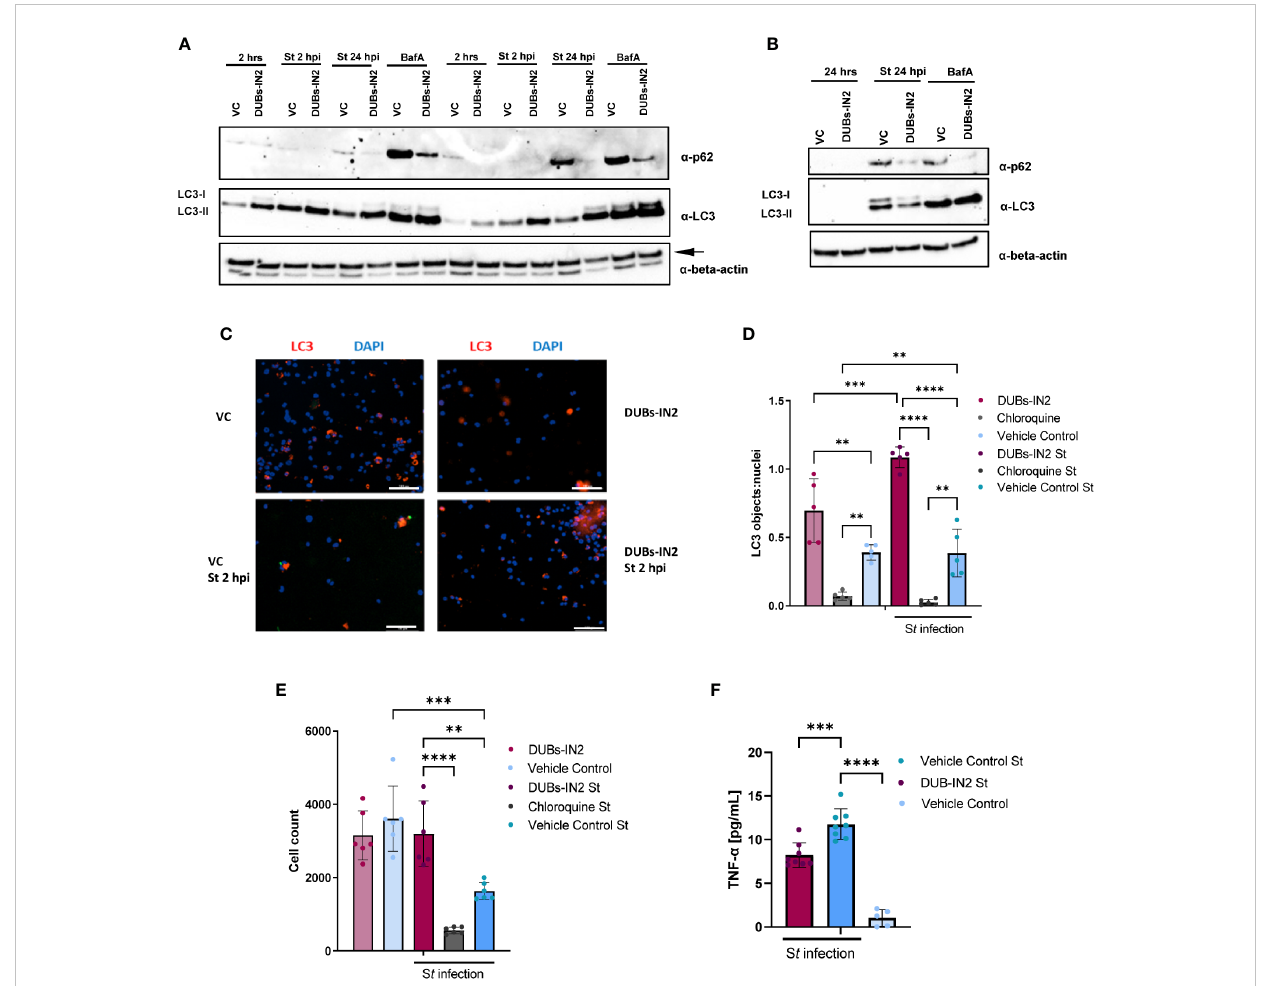
FIGURE 5 USP8 inhibition down-regulates p62 in human THP-1 macrophages during S. Typhimurium infection. (A) . THP-1-derived macrophages were treated with 2.5 µM DUBs-IN2 or vehicle control (VC) for 2 hours and then infected with S. Typhimurium (St) wild-type (MOI 50:1) for 2 hours or 24 hours (2 hpi